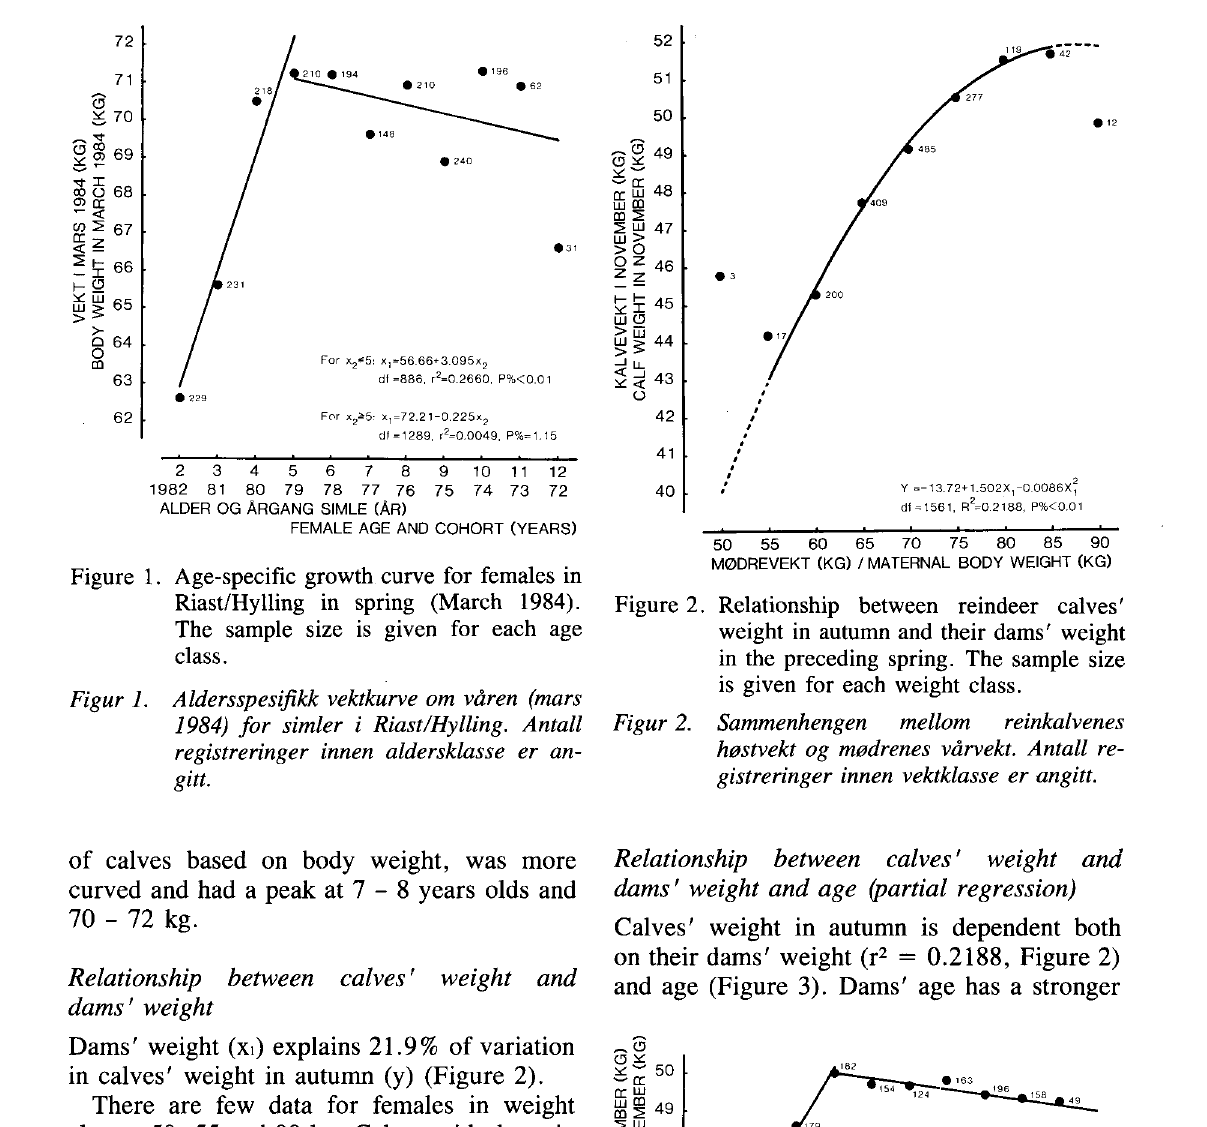
Figure 2. Relationship between reindeer calves' weight in autumn and their dams' weight in the preceding spring. The sample size is given for each weight class. Figur 2. Sammenhengen mellom reinkalvenes høstvekt og mødrenes vårvekt. Antall re gistreringer innen vektklasse er angitt.